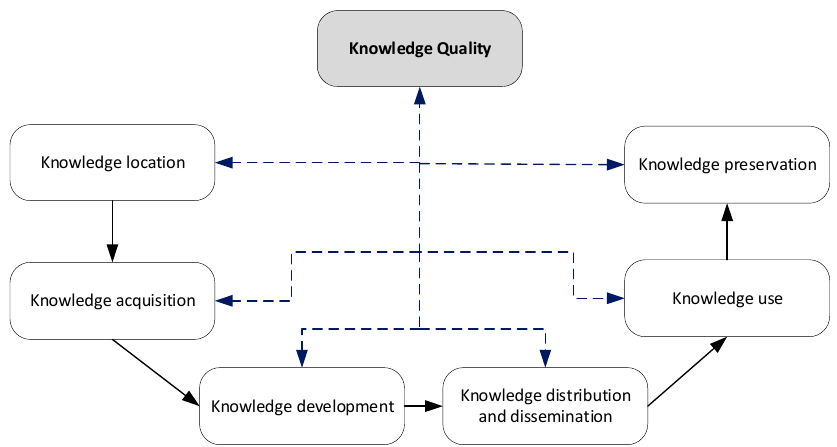
Figure 1. Elements of the knowledge management process Source: own elaboration based on [37].